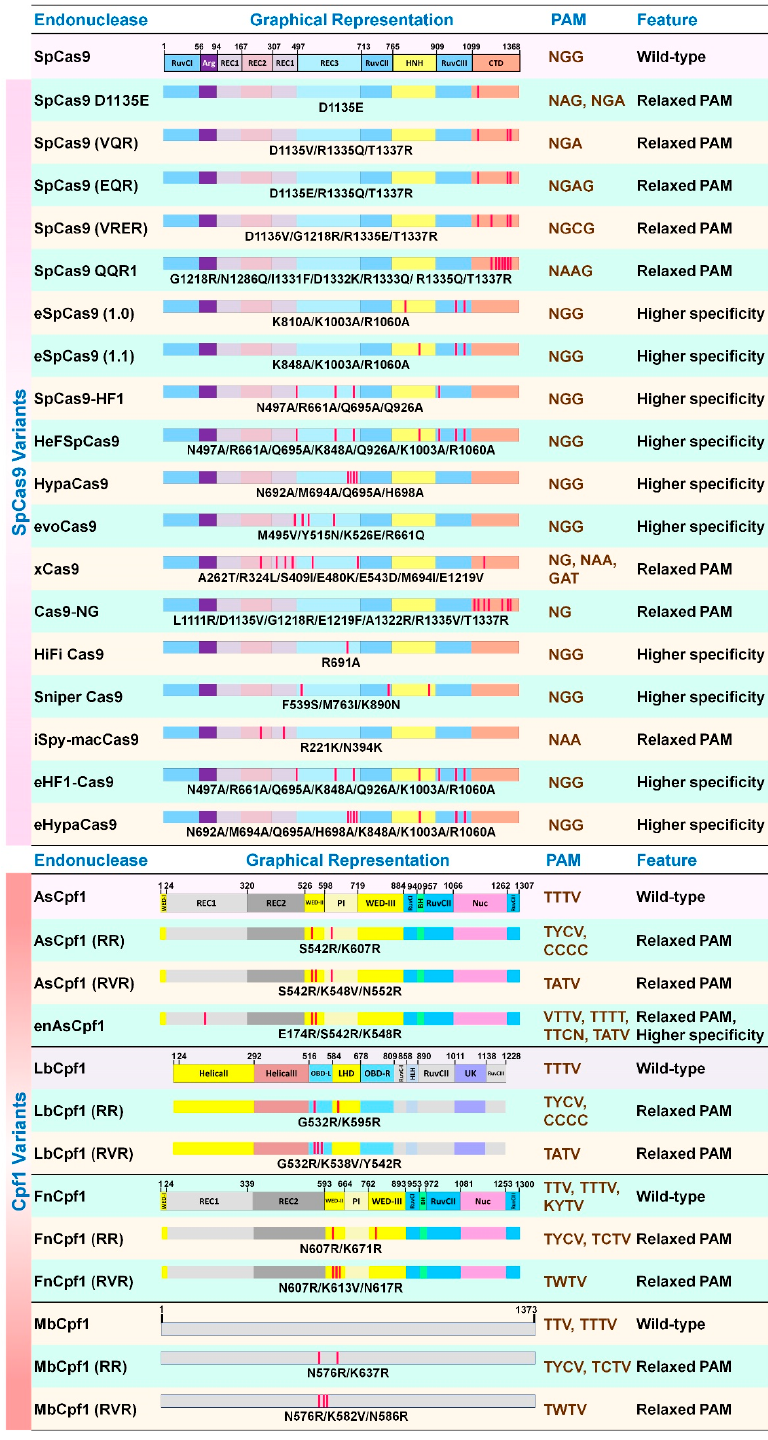
Figure 4. Schematic representation of Cas9 and Cpf1 variants including domain organization. Color scheme and nomenclature to represent domains followed from published structures for each enzyme. MbCpf1 structure is not yet available, hence protein domains are not drawn. Abbreviations: RuvCI-III, RuvC nuclease domain; Arg, arginine-rich bridge helix; REC1-3, recognition lobe; HNH, HNH-like nuclease domain; CTD, C-terminal domain; WEDI-III, wedge domain; PI, PAM-interacting domain; BH, bridge helix; Nuc, novel nuclease domain; OBD, oligonucleotide-binding domain; LHD, looped-out helical domain; HLH, helix-loop-helix; UK, domain with unknown